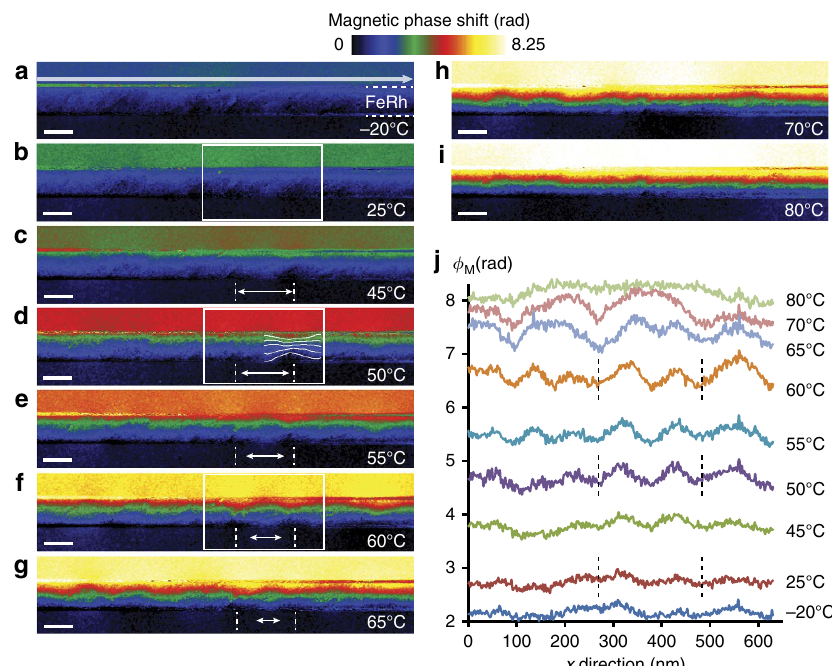
Figure 5 | Main stages of the transition while increasing temperature. ( a – i ) Magnetic phase images. The colour scale is common to all images and scale bars represent 50nm. On the phase image recorded at 50 (cid:2) C ( d ) are displayed the isophase lines parallel to the induction lines: the narrowing corresponds to a local increase of the phase variation and the appearance of ferromagnetic domains. The two dotted lines into the MgO part are centred on two ferromagnetic domains and the double arrow between them corresponds to the approximate width of the enclosed antiferromagnetic domain. The areas enclosed by the white rectangles for phase images at 25 (cid:2) C ( b ), 50 (cid:2) C ( d ) and 60 (cid:2) C ( f ) are used for micromagnetic simulations presented Fig. 6. ( j ) Phase profiles extracted for different temperatures along the upper interface (large arrow on the magnetic phase image obtained at (cid:2) 20 (cid:2)